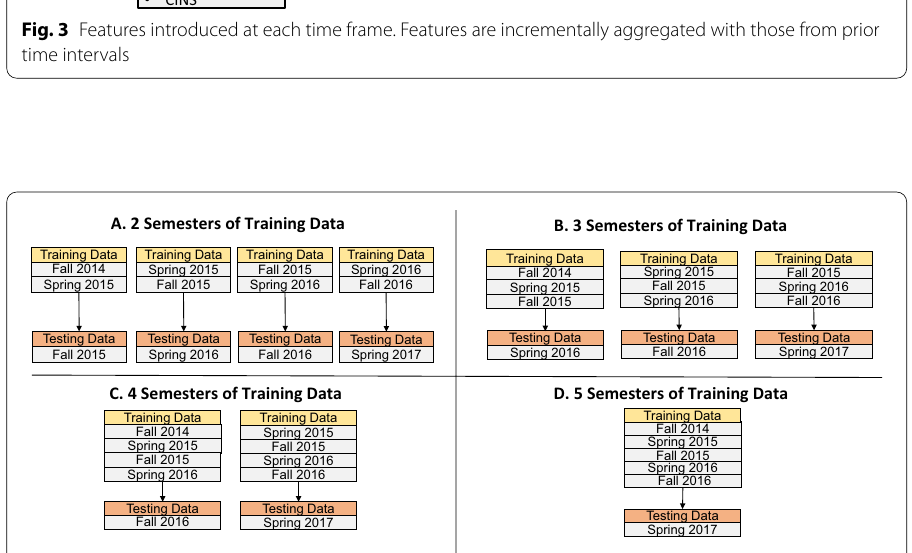
Fig. 4 Prediction methodology overview. Modified from Bertolini et al. (2021)